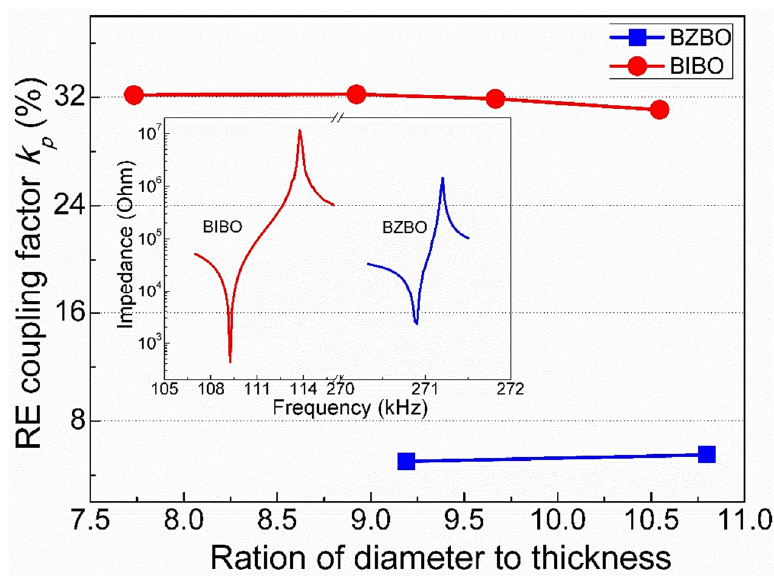
Figure 5. The radial extensional electromechanical coupling factor k p for the α-BIBO and BZBO crystals.